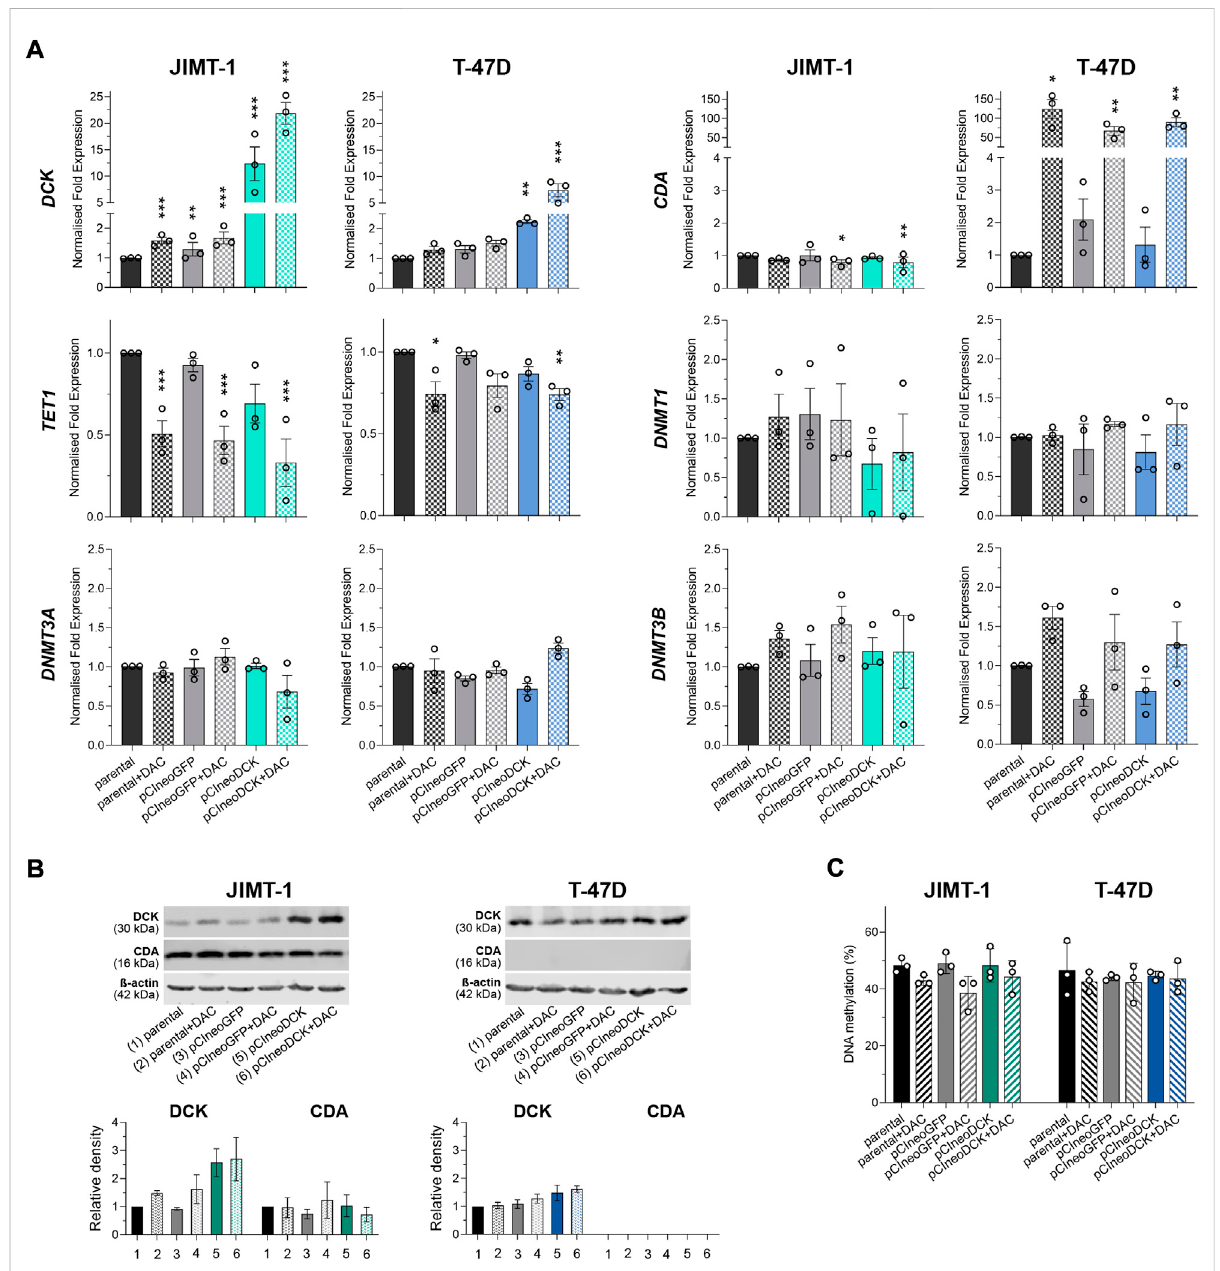
FIGURE 3 Gene and protein expression of enzymes involved in pyrimidine metabolism after transient transfection with DCK plasmid. (A) DCK , CDA , TET1 , DNMT1 , DNMT3A , and DNMT3B gene expression changes in JIMT-1 and T-47D cells due to pCIneoDCK transfection and DAC exposure. Mean valuesfromthreeindependentexperimentsareexpressedasnormalizedgeneexpressioncomparedtoparentalcells;errorbarsrepresentSEM;* p < 0.05,** p < 0.01,*** p < 0.001; (B) Representativeresults ofWesternblotanalysis forDCKand CDAexpressionafter individual treatments andits quanti fi cation by densitometry from three experiments; (C) LINE-1 DNA methylation in parental and transfected JIMT-1 and T-47D cells, evaluated by pyrosequencing. DNA methylation values (%) are presented as mean ± SEM. No signi fi cant differences were